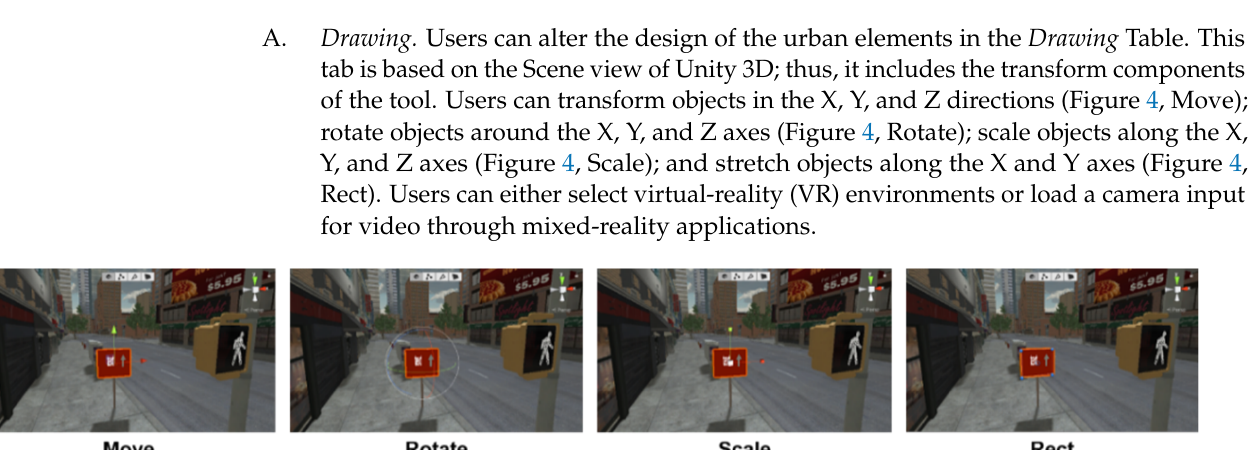
Figure 4. Object transform functions. Users can move, rotate, scale, and rect (two-dimensionally scale) target objects.